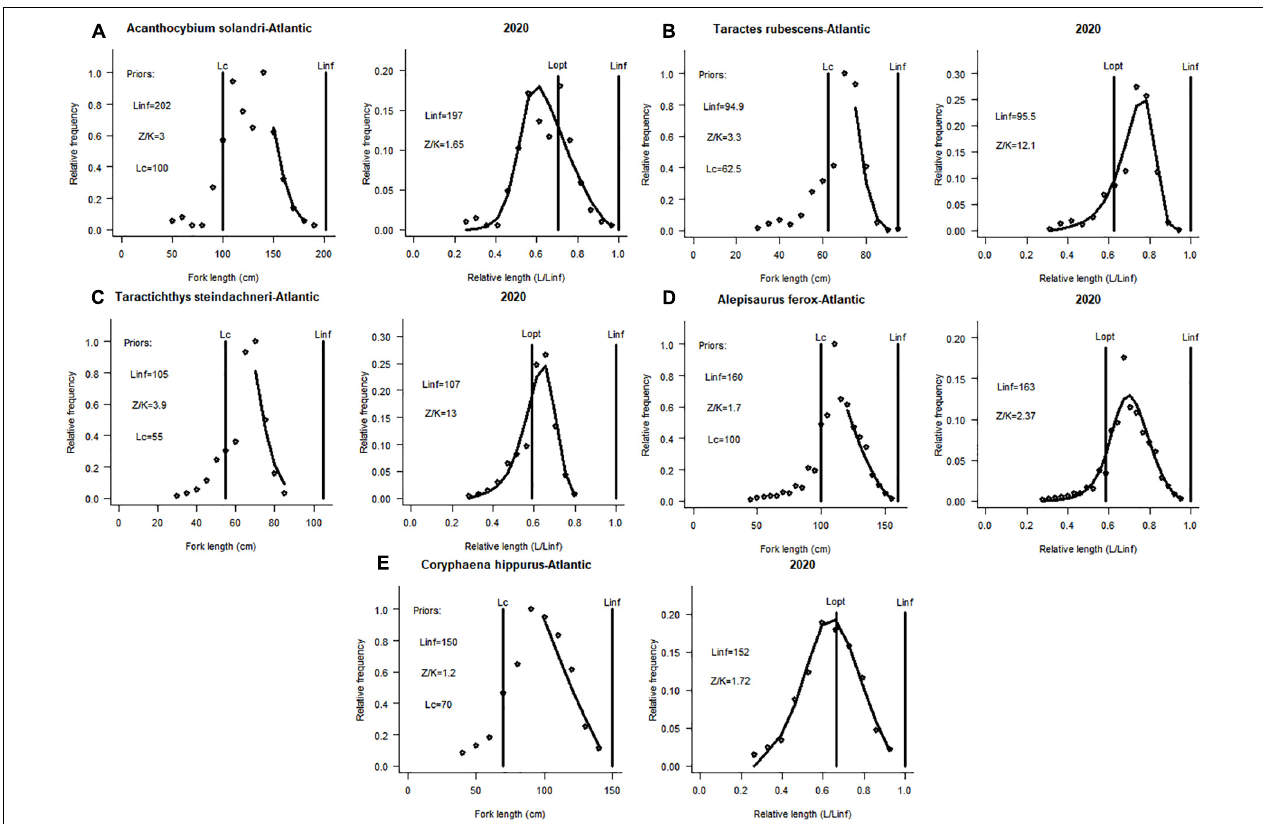
FIGURE 1 | Application of the LBB method to five non-target species (with available length-frequency data) caught by the Chinese tuna longline fisheries vessels operating in the Atlantic Ocean (see also Table 1 and Supplementary Materials ). LBB plots for (A) Acanthocybium solandri (B) Taractes rubescens (C) Taractichthys steindachneri (D) Alepisaurus ferox (E) Coryphaena hippurus